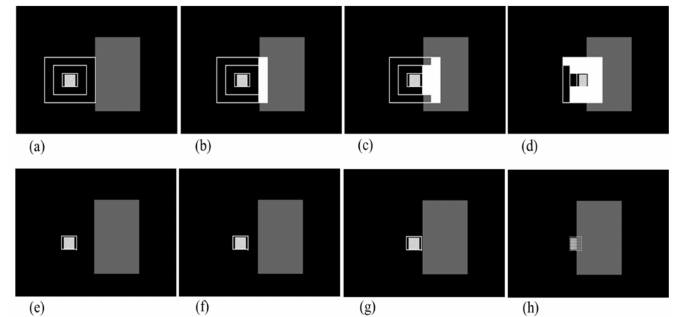
Figure 10. Result of background screening obstacle check in test image sequence. ( a – d ) show the process of gates’ pollution over frames by obstacle; ( e – h ) present the status of image tracking. In ( h ), the background screening alarm finally occurs.